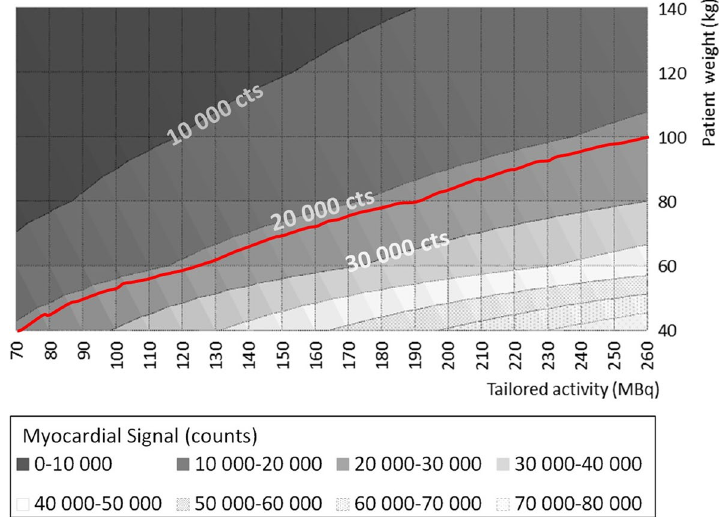
Fig. 6 Diagram depicting the dual‑dependency relationship between myocardial signal, patient weight, and injected activity. The theoretical expected myocardial signal was computed using Eq. 2. Uncertainty derived from Eq. 2 leads to a constant relative uncertainty of 23% over the predicted myocardial signal. Applying a myocardial signal threshold of 22,000 counts (red line) means that patients with a body weight of < 100 kg